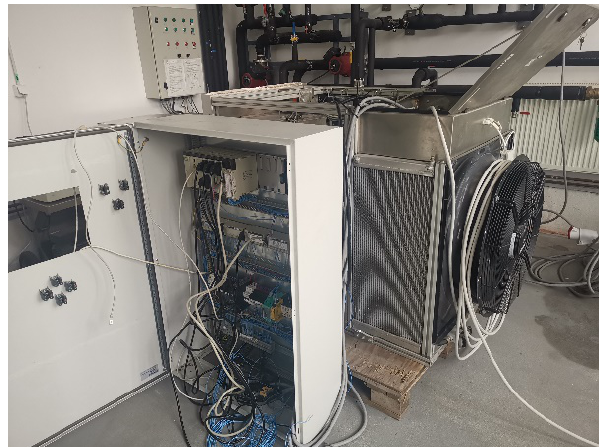
Figure 11. CPU and automation panel.